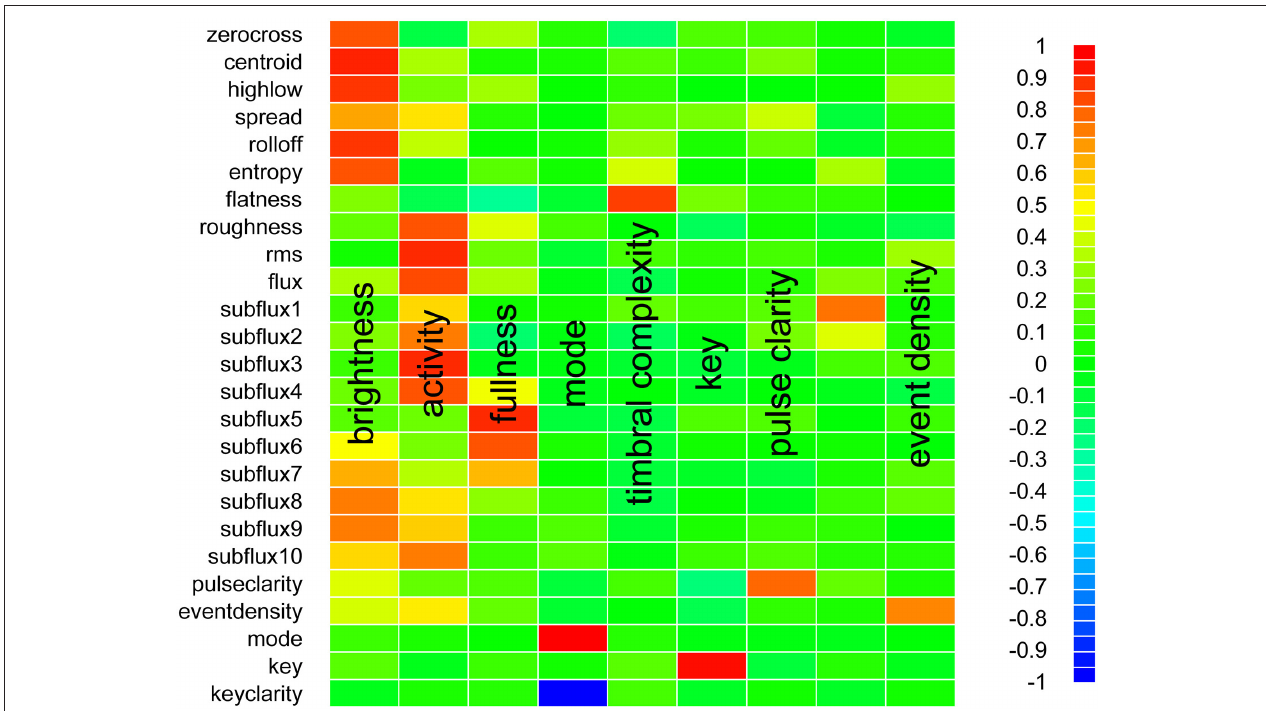
FIGURE 1 | Principal component loadings of the music information retrieval features of musical stimuli. Music information retrieval (MIR) features derived from all musical stimuli (both peak and pre peak musical recommendations) were submitted to principal components analysis. Each row in the figure represents an MIR feature that was calculated for musical stimuli. Each column in the figure represents a component extracted from the MIR features of musical stimuli using principal component analysis. The shading of each cell indicates the loading of a given MIR feature on the respective principal component. The color bar on the right-hand side of the figure indicates the positive (red) or negative (blue) loading of each MIR feature on each principal component. Subjective labels for each principal component are overlaid on the figure. One of the components (represented in the 8th or penultimate column of the figure) did not map onto a previously identified perceptual dimension, and thus remains